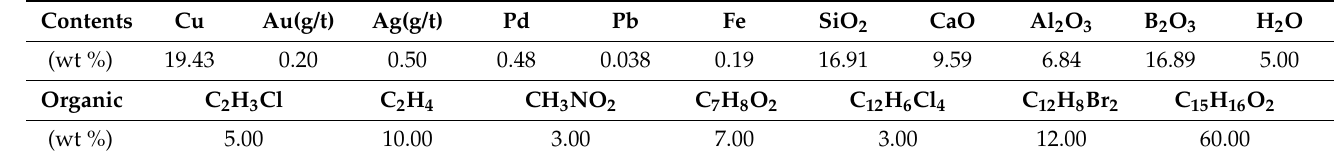
Table 3. Chemical compositions of the cutout of copper-clad